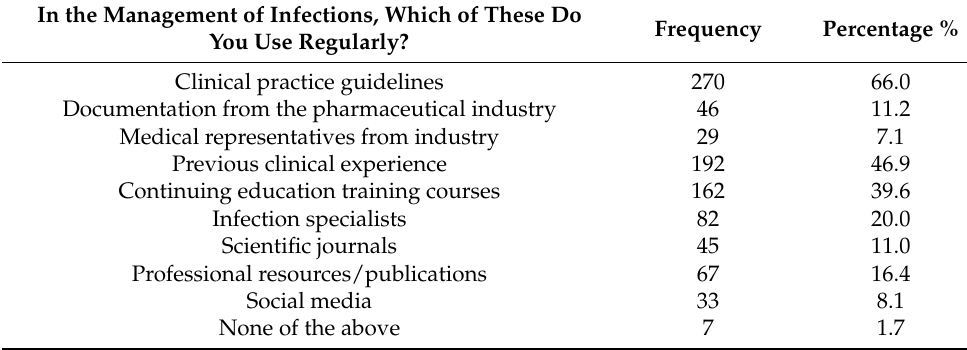
Table 2. Resources used for management of patients with infections.